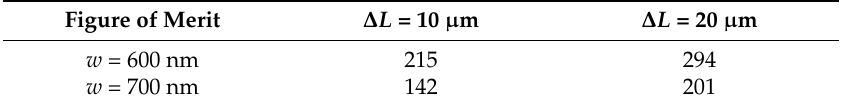
Figure of Merit